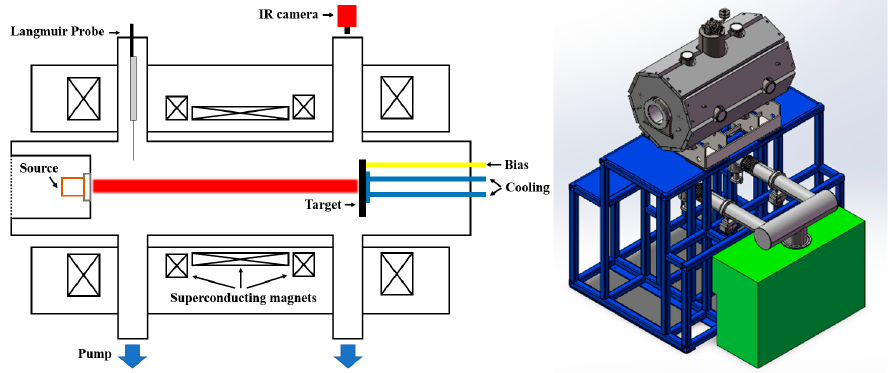
Figure 1. The conceptual drawing ( left ) and schematic design ( right ) of HIT-PSI. Table 1. Parameters of ITER required and existing/designed devices.